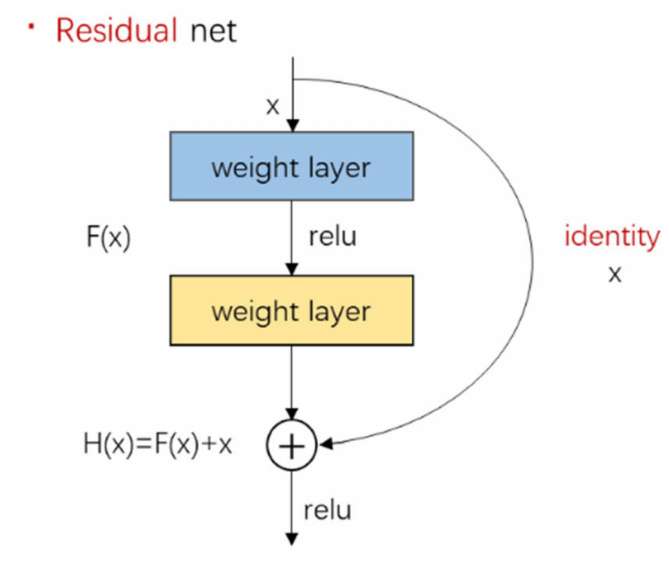
Figure 3. Residual learning